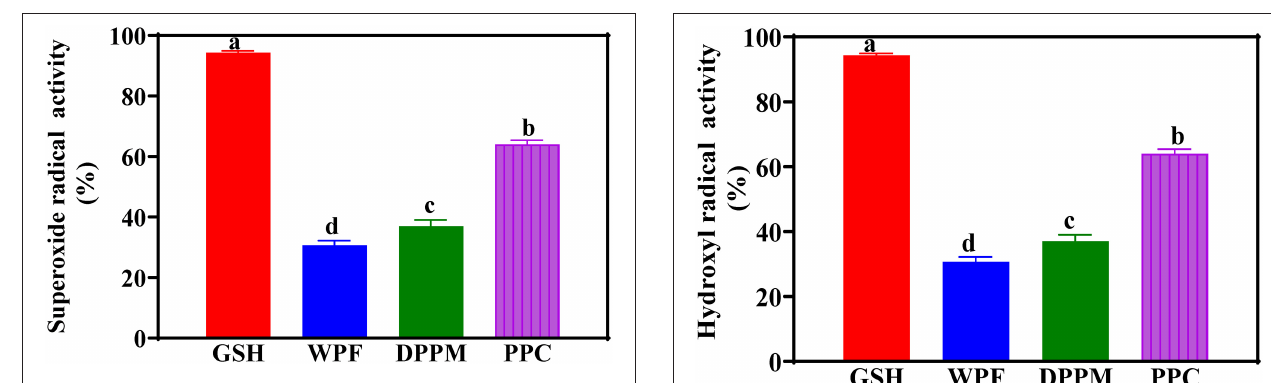
FIGURE 3 | Hydroxyl radical scavenging activities of different peanut protein preparations (WPF, whole peanut flour; DPPM, defatted peanut protein meal; PPC, peanut protein concentrate) in comparison to glutathione (GSH) a natural antioxidant. Values are means ± std and bars with different letters are significantly different at p < 0.05.